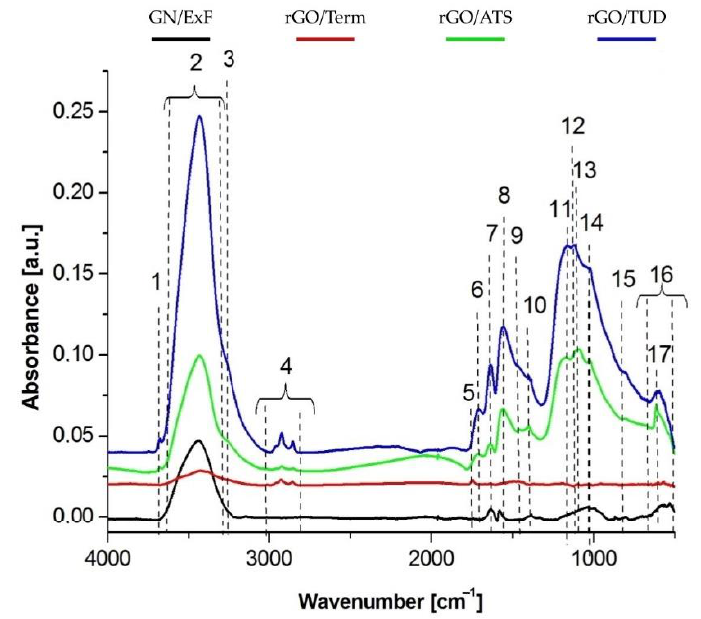
Figure 2. Fourier transform infrared (FTIR) spectra of graphene (GN/ExF; black line) and reduced graphene oxides (rGO/Term, red line; rGO/ATS, green line; rGO/TUD, blue line). The individual digital markings on the graph show the bands associated with the occurrence of individual functional groups; 1 (OH-), 2 (OH-), 3 (N-H), 4 (C-H), 5 (C=O), 6 (C=O), 7 (C=C), 8 (COO-), 9 (C-H), 10 (-OH), 11 (C-O-C), 12 (C-NH 2 /C-N), 13 (C=S), 14 (carbon ring), 15 (CH 2 =CH), 16 (carbon ring), 17 (C-S/S-O). Abbreviations : GN, graphene; rGO, reduced graphene oxide; FTIR, Fourier transform infrared; a.u., absorbance unit; ExF, exfoliation; Term, thermal; ATS, ammonium thiosulphate; TUD, thiourea dioxide. Table 1. Location of absorption bands exhibited by the functional groups in FTIR spectra obtained for individual GN and rGO samples.